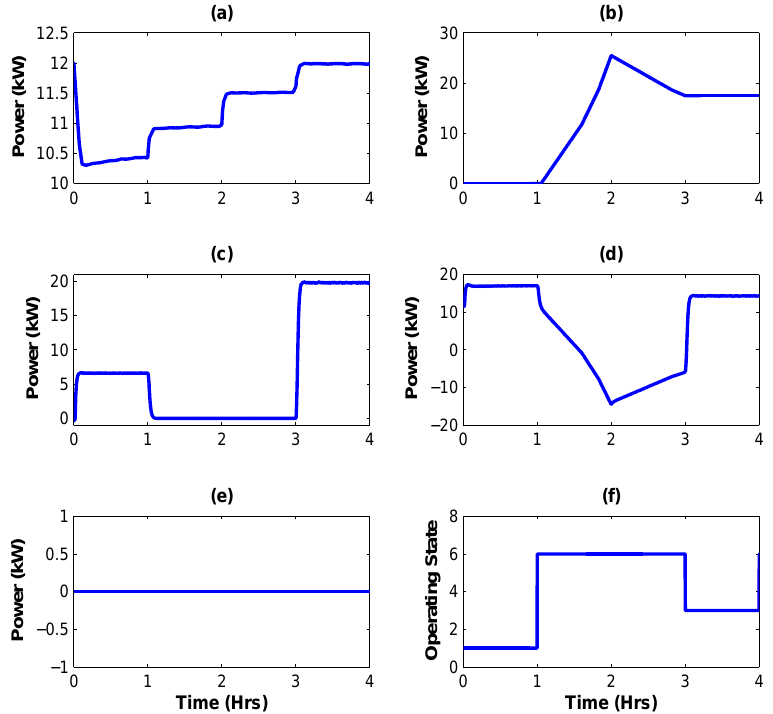
Figure 16. Simulation results for t = 0–4 h; ( a ) P DL , ( b ) P WT , ( c ) P CDi , ( d ) P NG , ( e ) P ES , ( f ) operating